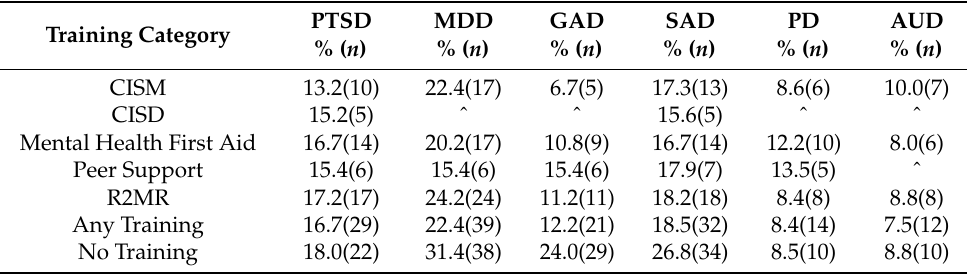
Table 3. Prevalence of screening positive for mental disorders among individuals who have had different mental health training